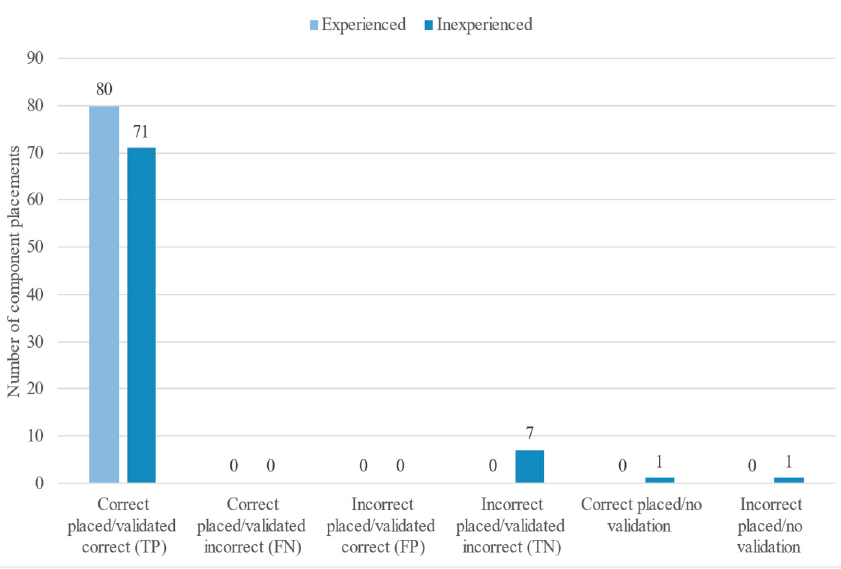
Figure 14. Component placement validation results for experienced and inexperienced users.